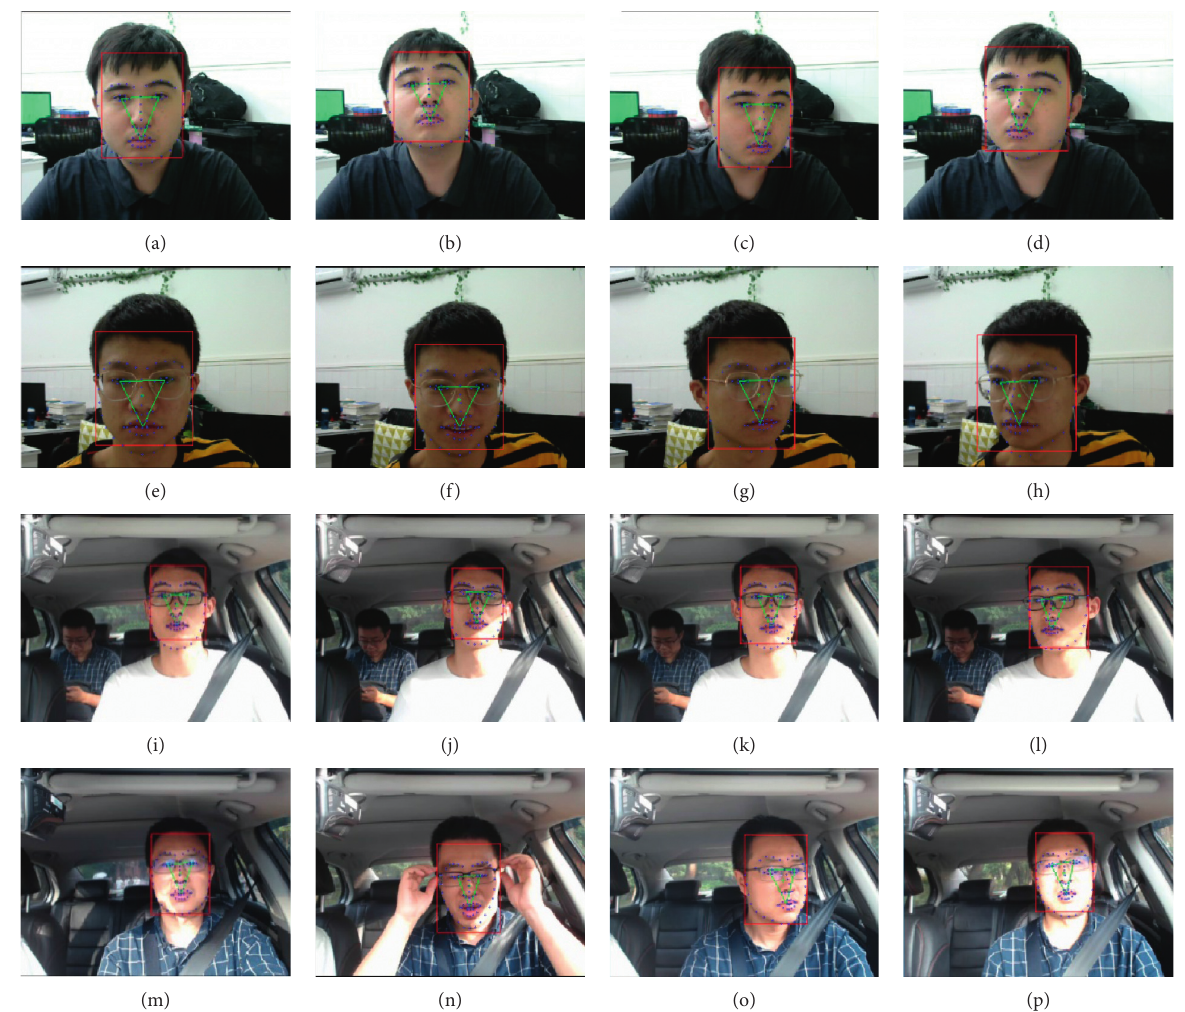
Figure 13: The results of face detection and feature point location. (a) (1-1). (b) (1-2). (c) (1-3). (d) (1-4). (e) (2-1). (f) (2-2). (g) (2-3). (h) (2-